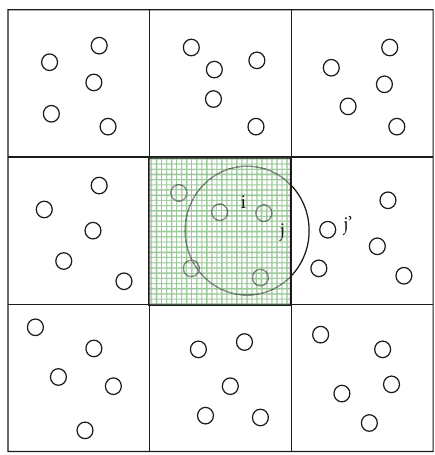
Figure 3: Schematic diagram of periodic boundary conditions.